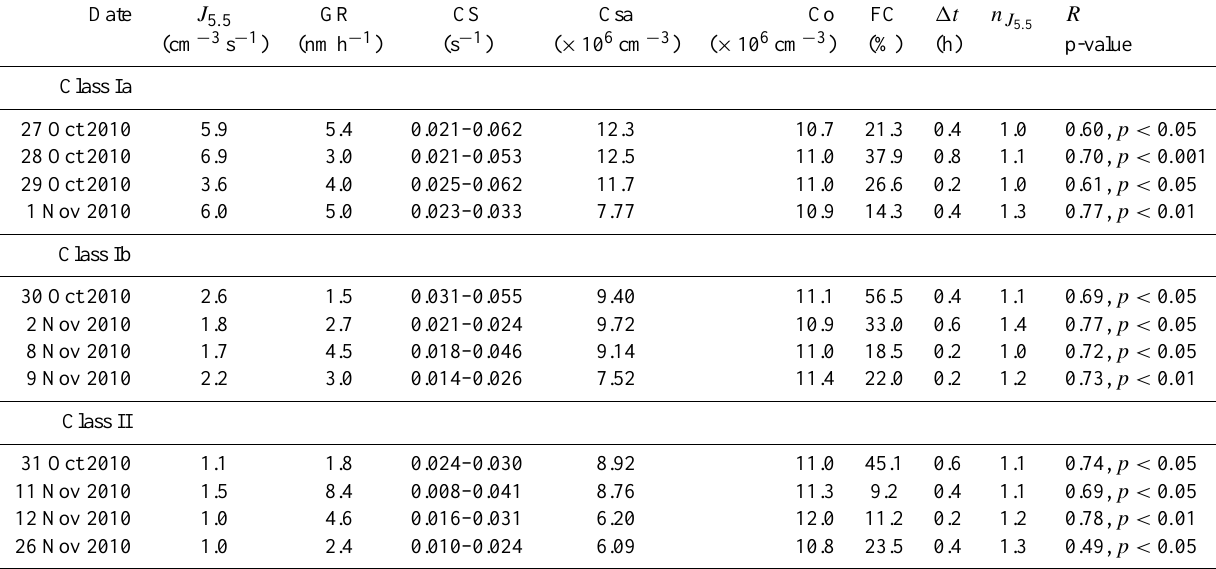
Table 2. Particle formation rate ( J 5 . 5 ) , growth rate (GR), minimum and maximum condensation sink (CS), sulfuric acid (SA) vapor concen- tration (Csa), the SA vapor needed for 1nmh − 1 particle size growth (Co), fractional contribution of SA vapor to particle growth (FC), fitted time delay ( 1t ) and the exponent ( n J ) for the correlation of J 5 . 5 with sulfuric acid for each NPF event day covering 06:00–18:00LT with 5 . 5 p-value of the